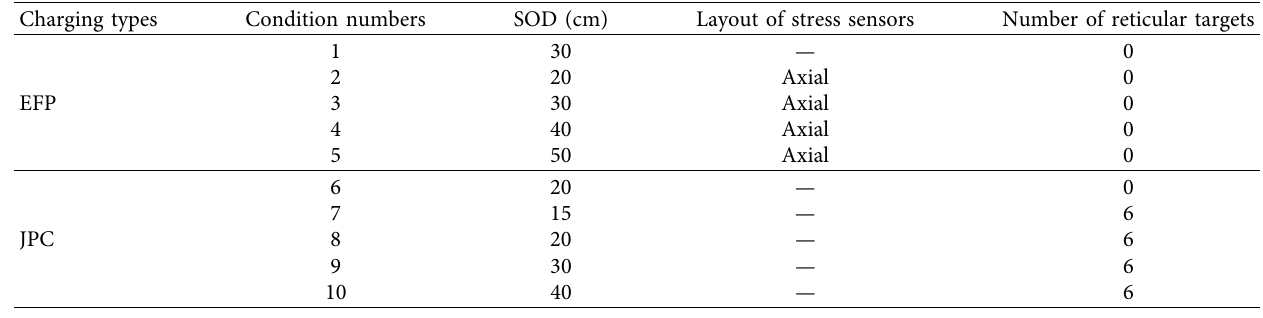
Figure 6: Bracket for the test module. (a) Test module. (b) Table 1: Test conditions.